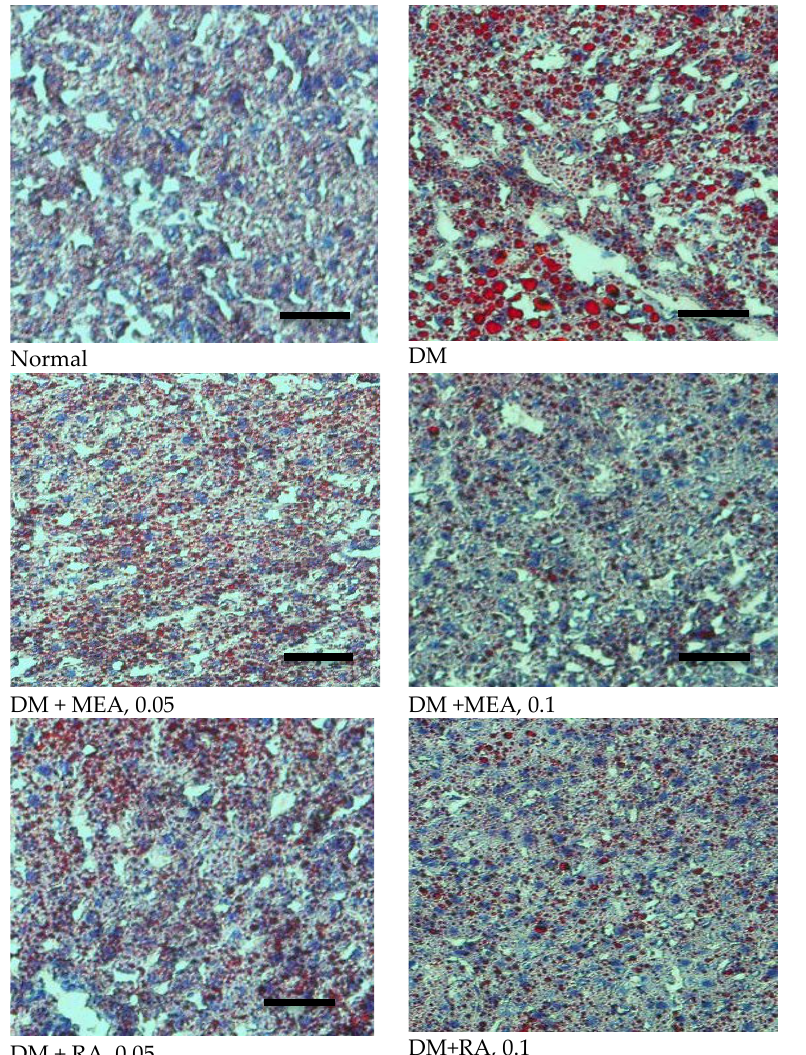
Figure 3. Effects of MEA and RA upon hepatic lipid accumulation, determined by ORO statin in normal (non-diabetic), diabetic mice consumed normal diet (DM), or 0.05%, 0.1% MEA or RA for six weeks. A representative image is shown for each group. Scale bar: 50 μm. Magnification: 200×.